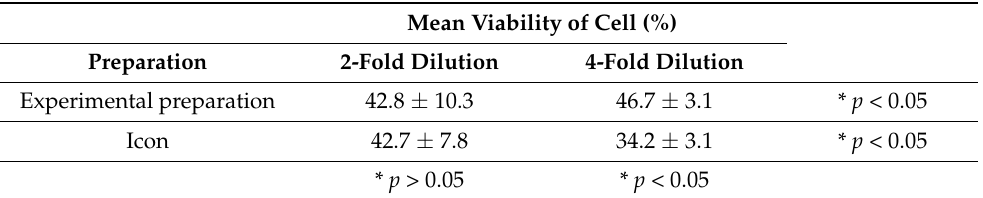
Table 1. Comparison of the mean viability of L-929 cells (%) after 24 h of incubation with a 2-fold and 4-fold dilution of the extract of the experimental preparation and the Icon preparation. Mean Viability of Cell (%) Preparation 2-Fold Dilution 4-Fold Dilution Experimental